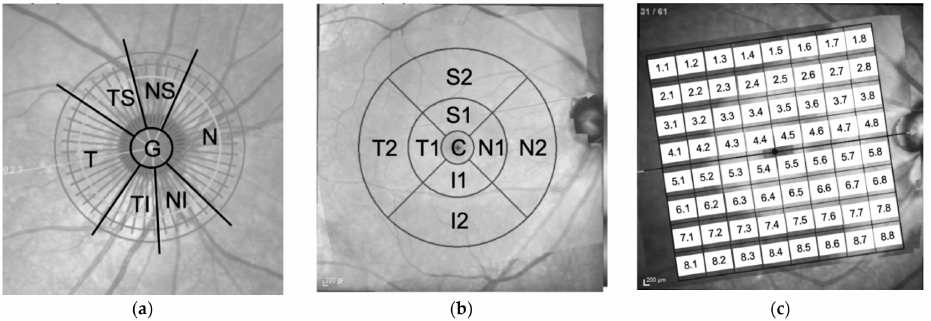
Figure 1. The labels of the location of ( a ) peripapillary retinal nerve fiber layer (ppRNFL) and Bruch membrane opening–minimum rim width (BMO-MRW) parameters, ( b ) retinal average thickness and thickness of each retinal layer in ETDRS grid, and ( c ) retinal average thickness in 8 × 8 grid. temporal (T), temporal inferior (TI), nasal inferior (NI), nasal (N), nasal superior (NS), temporal superior (TS), global (G), Superior (S), Inferior (I), Central (C). Table 1. Feature